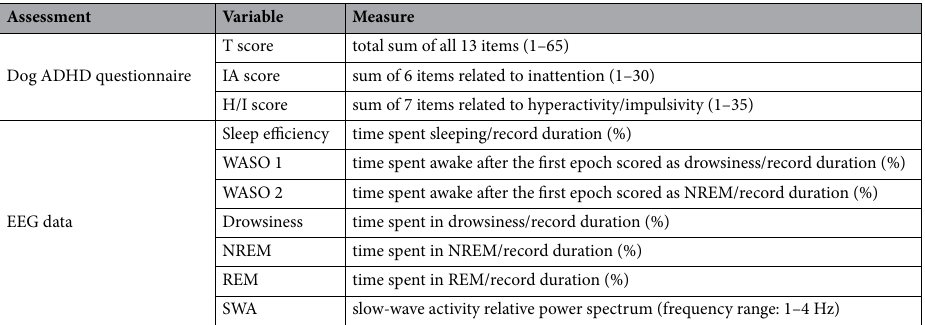
Table 1. Variables of interest regarding dogs’ ADHD questionnaire and sleep EEG data. (N)REM: (non)rapid eye movements sleep